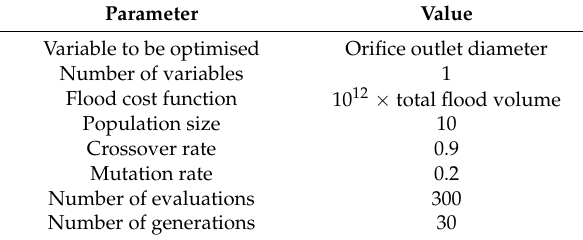
Table A7. Optimisation parameters adopted for the sizing of the orifice outlets for the